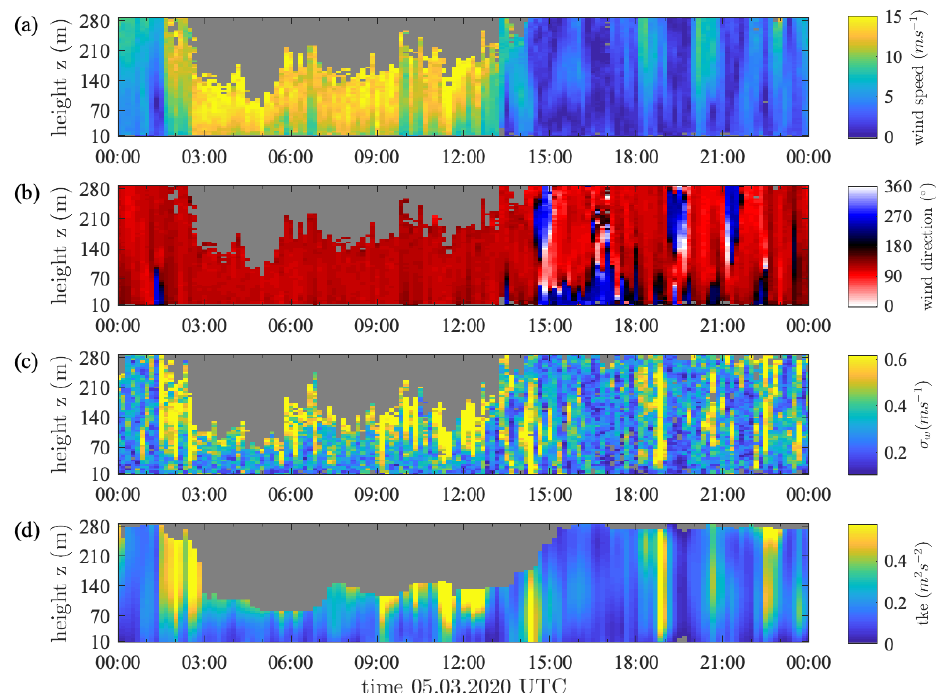
Figure 8. Time–height plots (sodargrams) observed with the minisodar data on 5 March 2020: (a) horizontal wind speed, (b) horizontal wind direction, (c) standard deviation of the vertical wind velocity σ w , and (d) turbulence kinetic energy (tke). Each pixel represents an average over the gate height of 5m and a period of 10min. Missing data are displayed in gray.